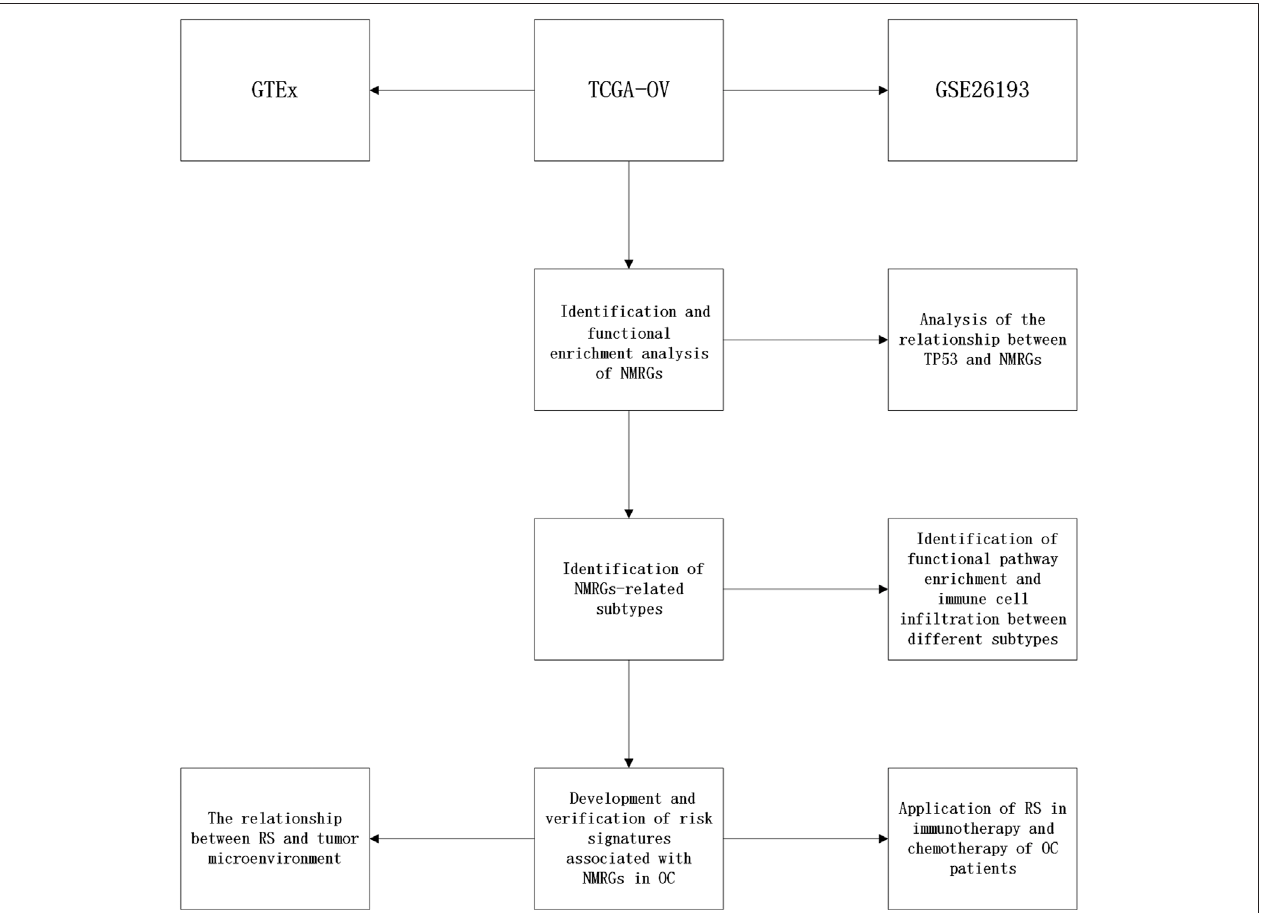
FIGURE 1 | Flowchart of this